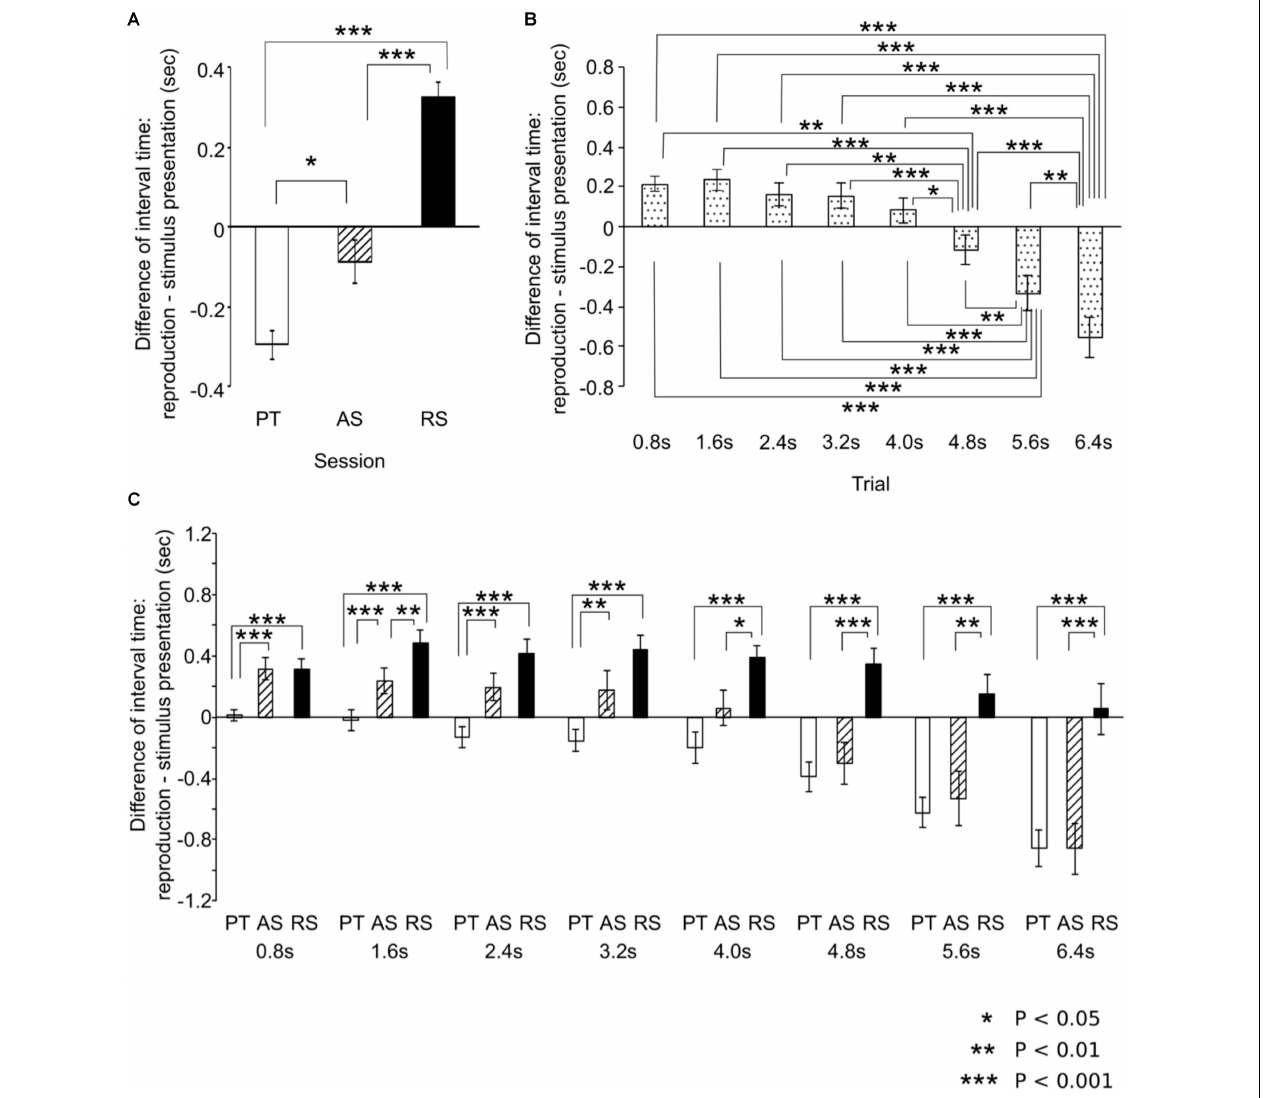
FIGURE 4 | The results of analysis of variances. Based on the main effects of session (A) and time intervals (B) and the interactions (C) , post hoc tests were conducted using the Bonferroni correction of significance probability ( p < 0.05). Until approximately 3 s, the results of the accelerando series sessions are similar to those of the rhythm series sessions whereas from approximately 4 s, they are similar to those of the paired tone sessions. The error bars indicate the standard error of the mean.